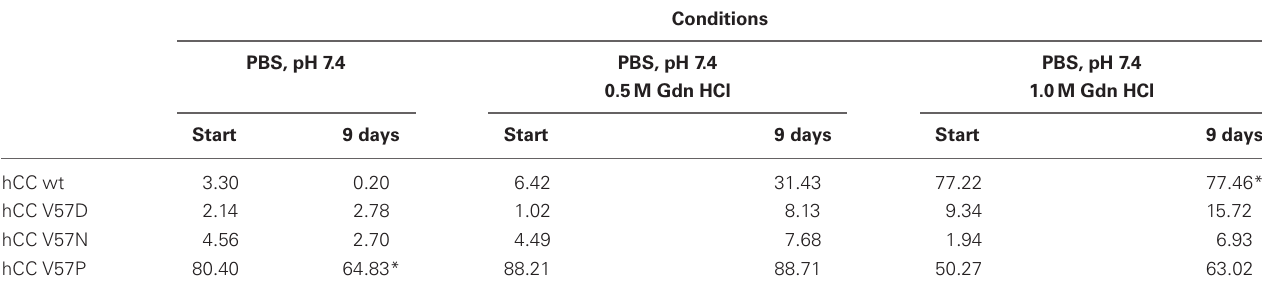
Table 1 | Dimer content (%) formed by cystatin C and its hinge loop mutants incubated in the presence of different concentration of guanidinium chloride (GdnHCl; Szyma´nska et al.,